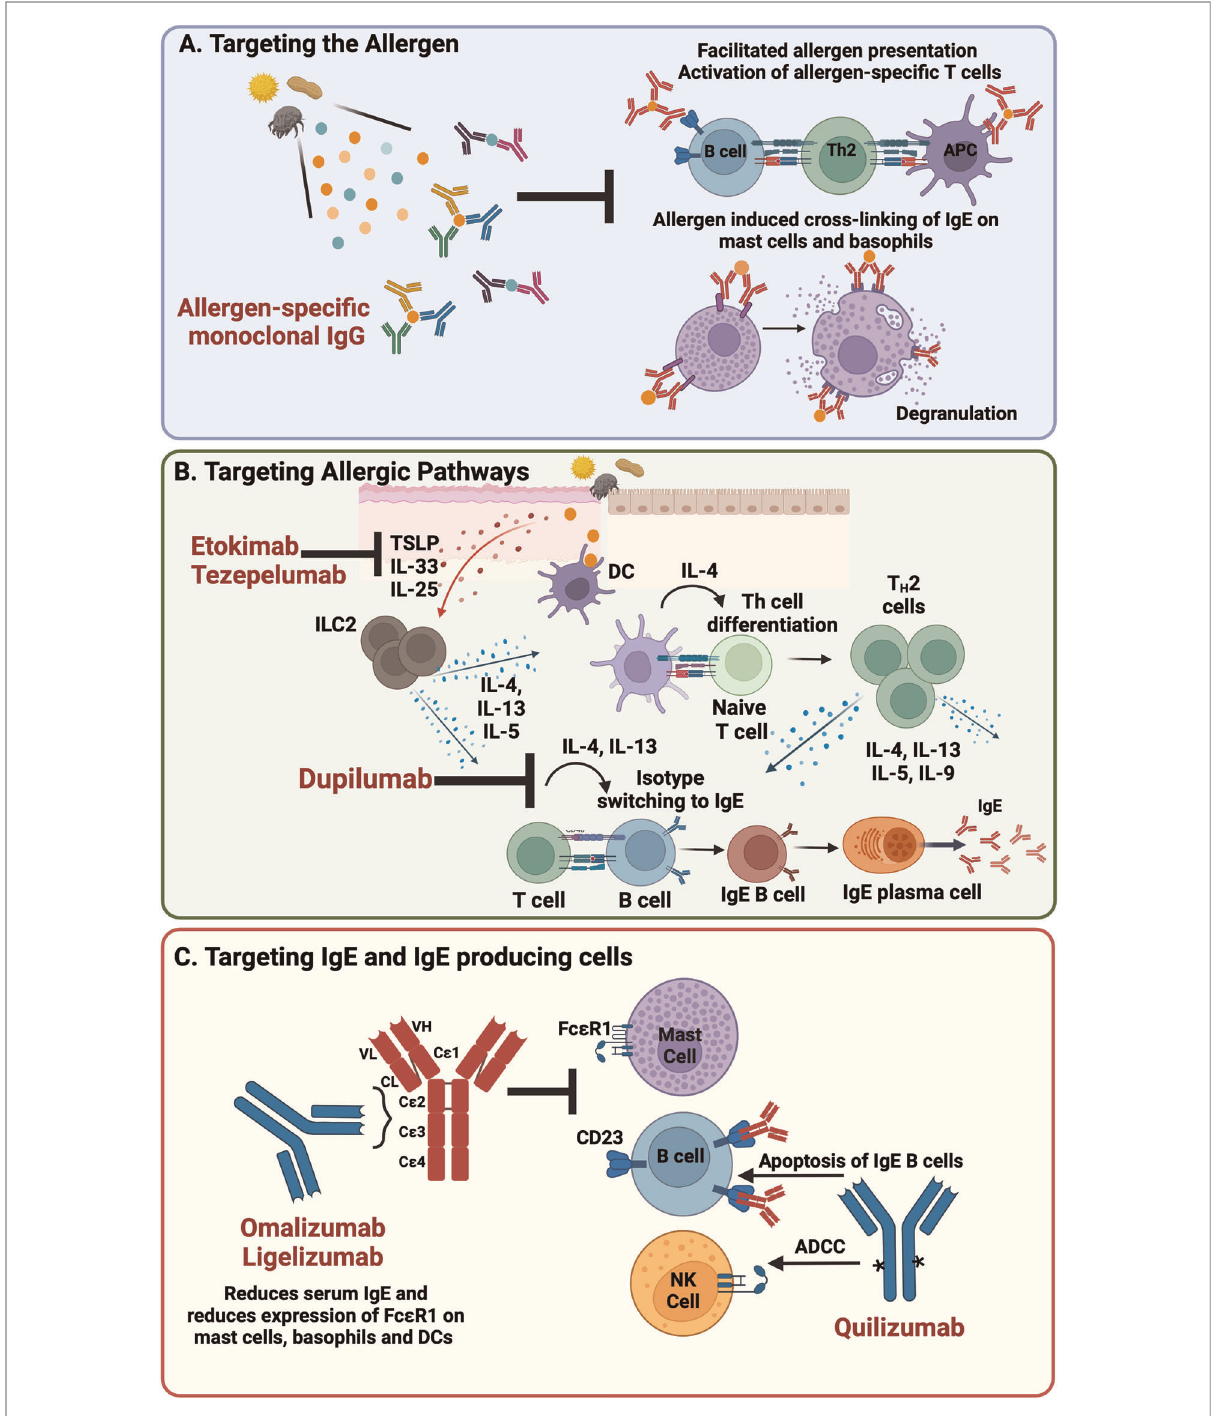
FIGURE 1 Targeted interventions for the treatment of IgE-mediated allergy ( A ). Passive administration of blocking IgG that binds allergen and inhibits allergen: IgE engagement on the surface of allergic effector cells prevents initiation of the allergic response and facilitated allergen presentation ( B ). Blockade of the epithelial-derived cytokines, TSLP and IL-33 and type 2 cytokines IL-4 and IL-13, present opportunities to inhibit initiation and maintenance of the allergic response ( C ). Directly targeting IgE and IgE-producing cells lowers the levels of IgE in circulation and decreases expression of Fc ε R1, the high af fi nity IgE receptor, on allergic effector cells thus blunting the allergic response (Made with Biorender.com); DC, dendritic cell; NK, natural killer; ADCC, antibody dependent cell-mediated